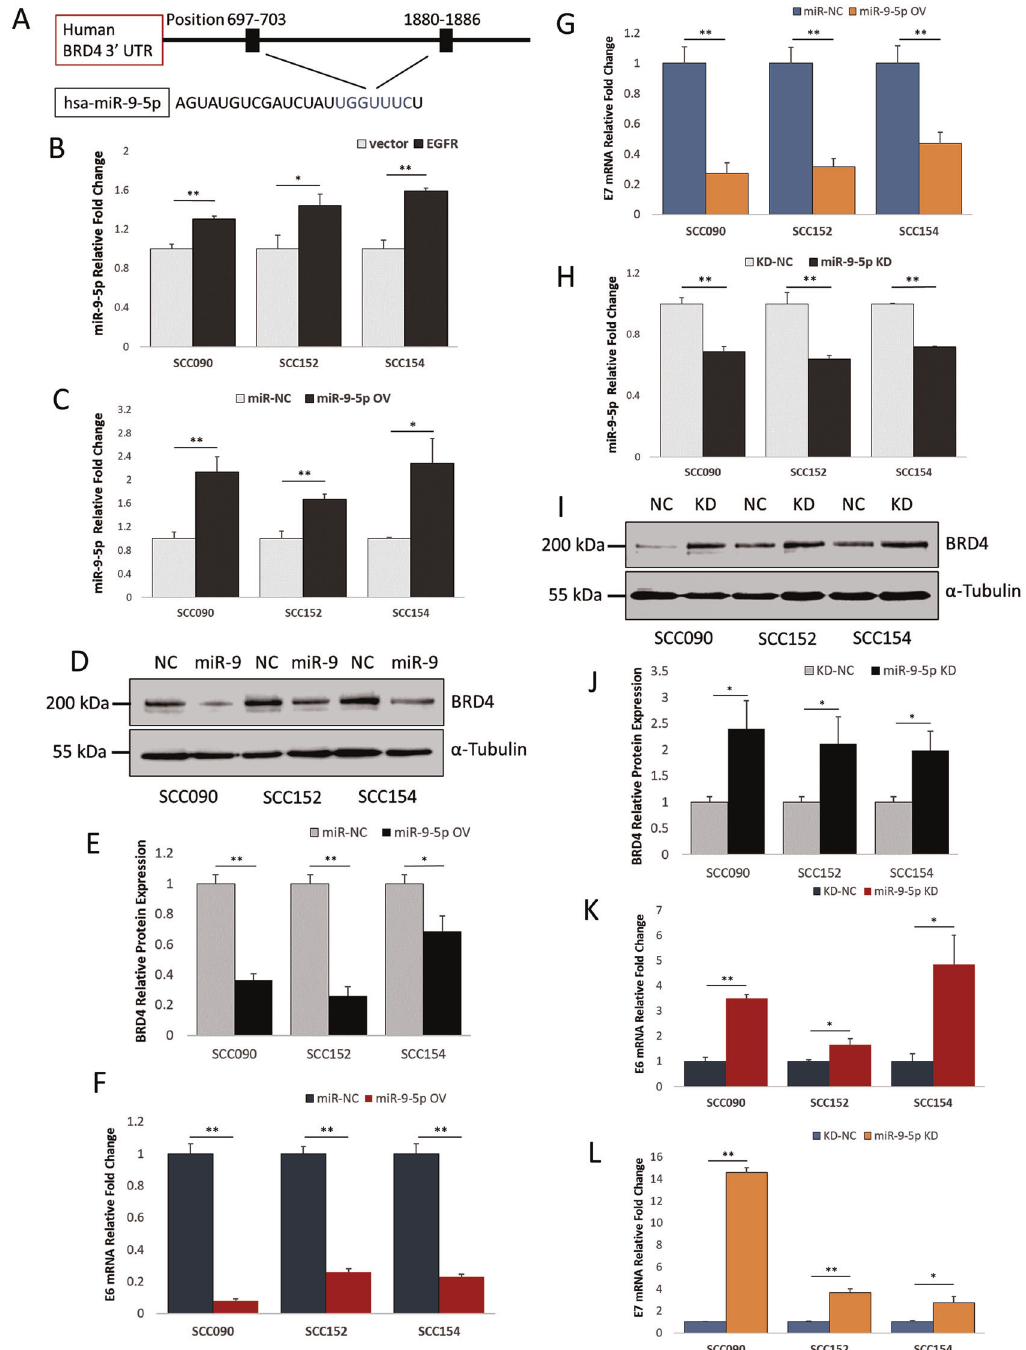
Fig. 4 miR-9-5p modulates BRD4 and HPV E6/E7 expression. A Binding sites of miR-9-5p in the 3 ’ UTR of human BRD4 predicted by TargetScan. B miR-9-5p expression in SCC090, SCC152 and SCC154 control cells and their EGFR-overexpressing counterparts as determined by qRT-PCR of three independent RNA extractions. Statistical analysis was performed by independent t test comparing each pair of the cells (vector vs EGFR) (* p < 0.05, ** p < 0.01). C miR-9-5p expression in miR-9-5p overexpressing cells (miR-9-5p OV) as determined by qRT-PCR of three independent RNA extractions, independent t test (* p < 0.05, ** p < 0.01), miR-NC – control (scrambled sequence). D BRD4 expression in SCC090, SCC152 and SCC154 in miR-9-5p (miR-9) overexpressing cells and their control counterparts (NC). E Quanti fi cation of three independent measurements of BRD4 expression in miR-9-5p overexpressing cells presented in bar-chart, independent t test (* p < 0.05, ** p < 0.01). HPV E6 ( F ) and HPV E7 ( G ) transcription in miR-9-5p overexpressing cells, comparisons were made within each cell line using independent t test (** p < 0.01). H miR-9-5p expression in miR-9-5p knockdown cells (miR-9-5p KD) as determined by qRT-PCR of three independent RNA extractions, independent t test (** p < 0.01), KD-NC – control (scrambled sequence). I BRD4 expression in SCC090, SCC152 and SCC154 in miR-9-5p (miR-9) knockdown cells and their control counterparts (NC) and their quanti fi cation of three independent measurements of BRD4 expression in miR-9-5p knockdown cells presented in bar-chart ( J ), independent t test (* p < 0.05), ( K ) and HPV E7 ( L ) transcription in miR-9-5p overexpressing cells, comparisons were made within each cell line using independent t test (* p < 0.05, ** p < 0.01).